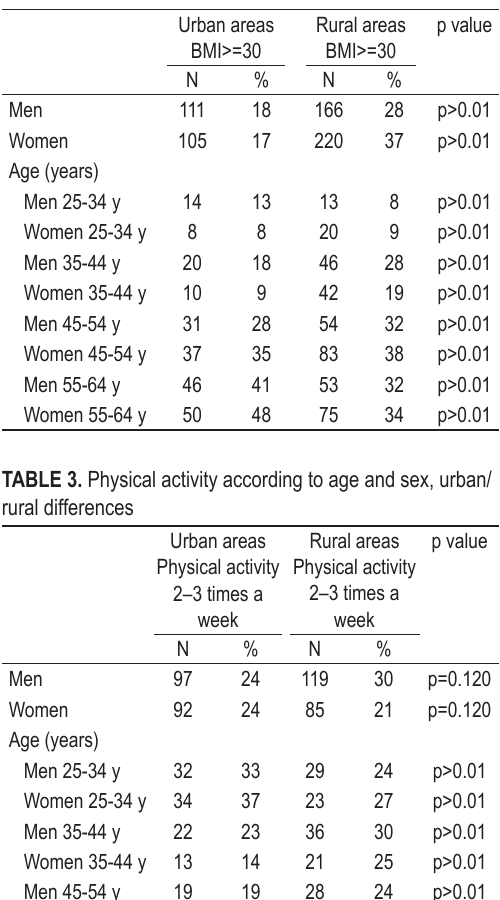
Table 2. Prevalence of obesity according to age and sex,